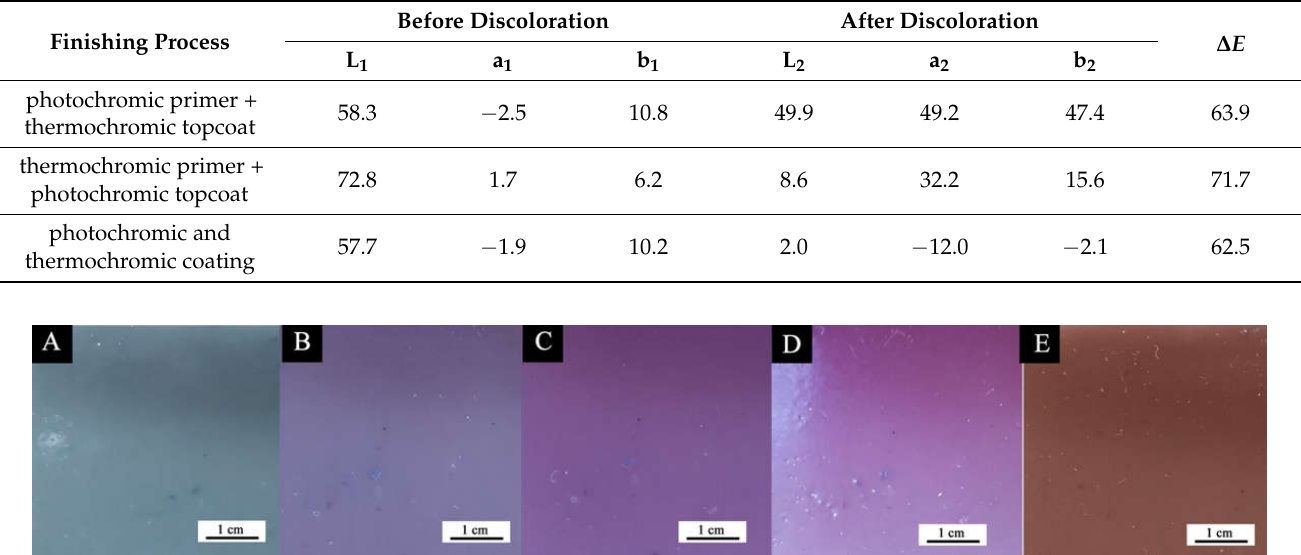
Figure 7. Photochromic diagram of the alkyd resin film with photochromic microcapsules and thermochromic microcapsules after different exposure times of visible light: ( A ) 0 s; ( B ) 5 s; ( C ) 10 s; ( D ) 15 s; ( E ) 20 s.